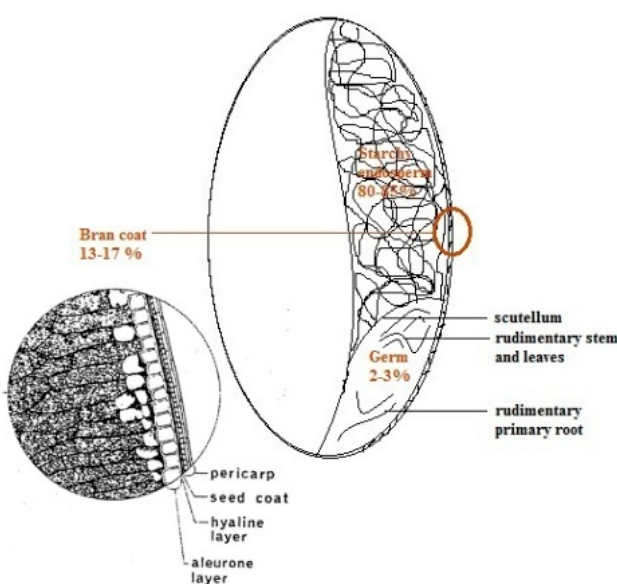
Figure 3. Schematic representation of wheat grain fractions (adapted from Reference [43]). Table 4. Bioactive compounds of wheat, oat and barley in whole grains and their bran fraction (g/100 g) (adapted by Vitaglione et al. (2008) [52]).